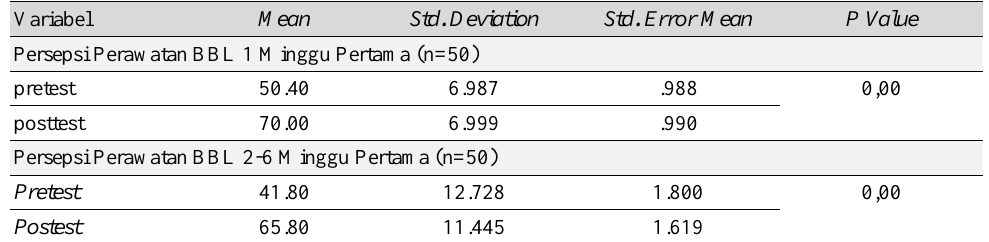
Tabel 11 Pengaruh Edukasi Postnatal Dengan Pendekatan FCMC Terhadap Persepsi Ibu Nifas dan